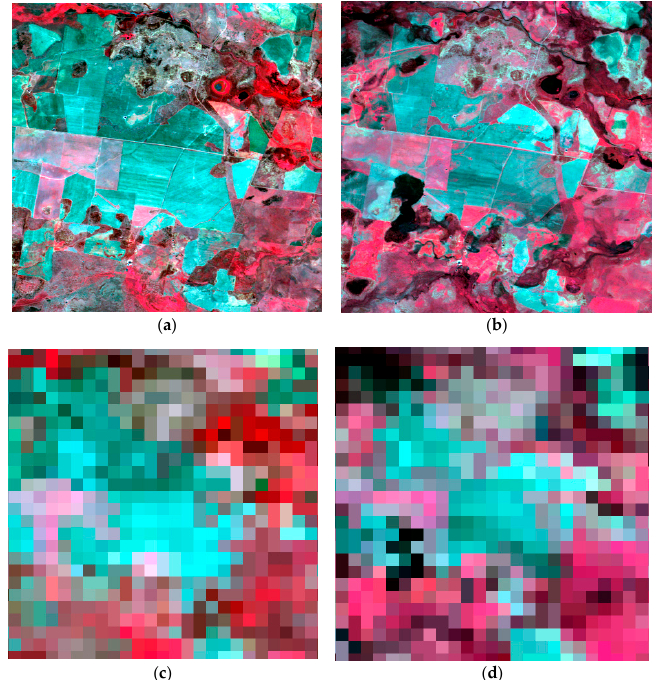
Figure 2. The first dataset exhibiting phenological changes: NIR-red-green composites of the Landsat images with a 30-m spatial resolution from ( a ) 2 May 2004 and ( b ) 5 July 2004; the corresponding MODIS images with a 500-m spatial resolution from ( c ) 2 May 2004 and ( d ) 5 July 2004.